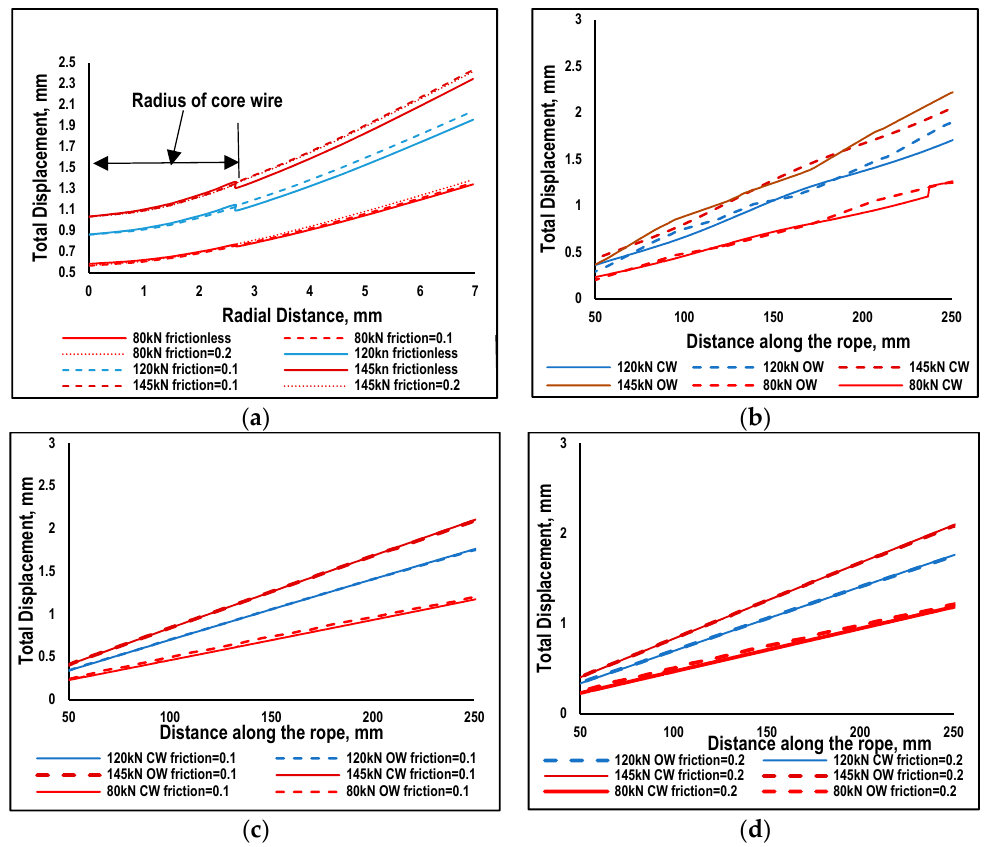
Figure 5. ( a ) Variation in Total Displacement along radial path at mid section of wire rope under different axial load and different surface conditions ( b ) Variation in Total Displacement in core and outer wire (OW)along the axis of wire rope under different axial loads in absence of friction ( c ) Variation in Total Displacement in core (CW) and outer wire (OW) along the axis of wire rope under different axial loads having coefficient of friction = 0.1. ( d ) Variation in Total Displacement in core (CW) and outer wire (OW) along the axis of wire rope under different axial loads having coefficient of friction = 0.2.